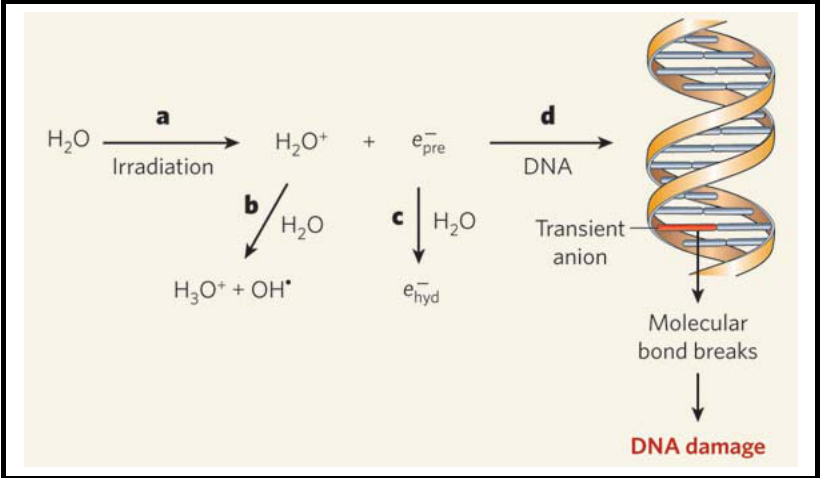
Figure 2. Mechanisms of radiation induced DNA damage. ( a ) Absorption of high-energy radiation by water molecules results in formation of H losing their kinetic energy, the electrons enter a short-lived, prehydrated state ( ).